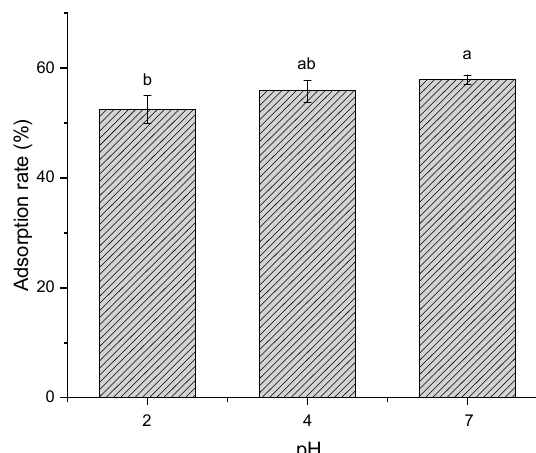
Figure 6. Adsorption efficiency of polyphenols from distiller’s grain with D101 resin (3 g) under the condition of 30 °C at 120 rpm for 24 h in an environment with different pH values of 2, 4, 7 and 9. Values with different letters (a, b) differ significantly ( P < 0.05) by Duncan’s multiple range test. Vertical bars represent the standard deviation of each value.